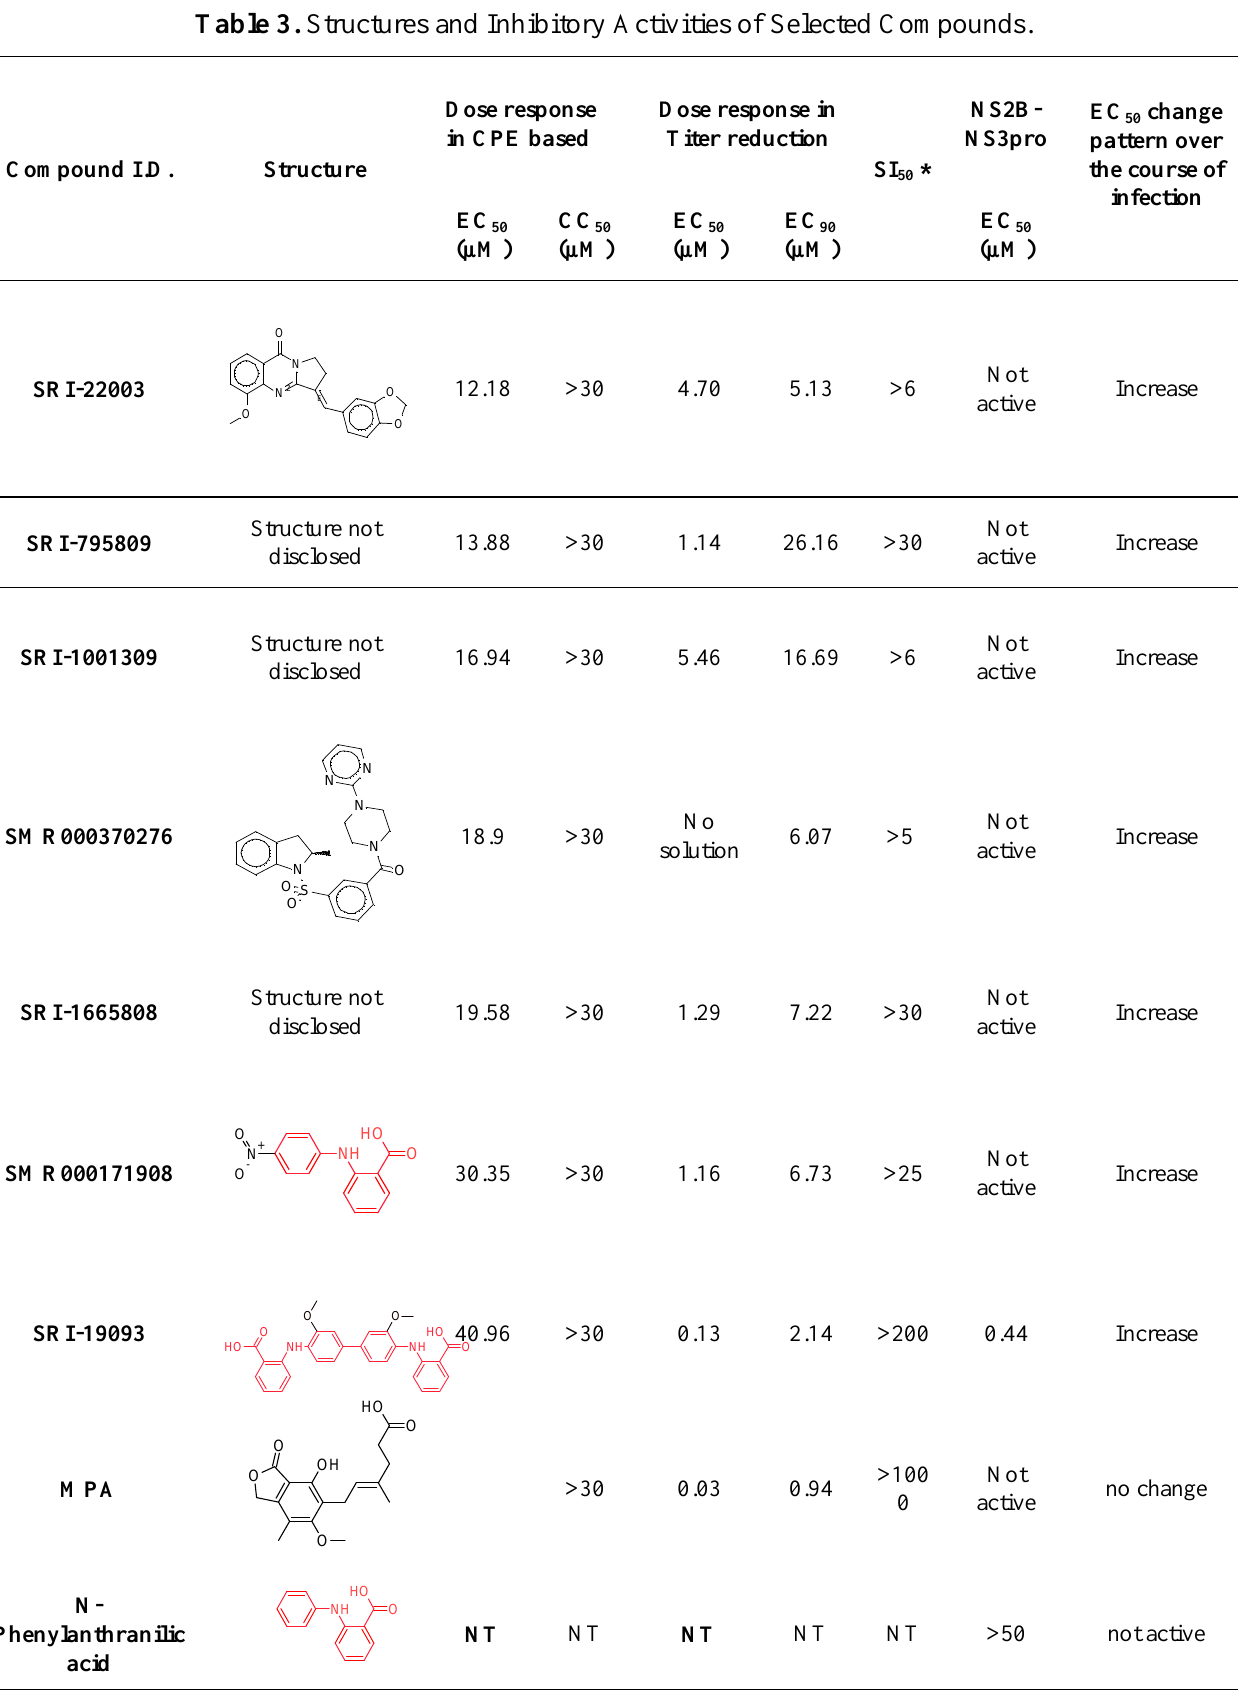
Table 3. Structures and Inhibitory Activities of Selected Compounds.